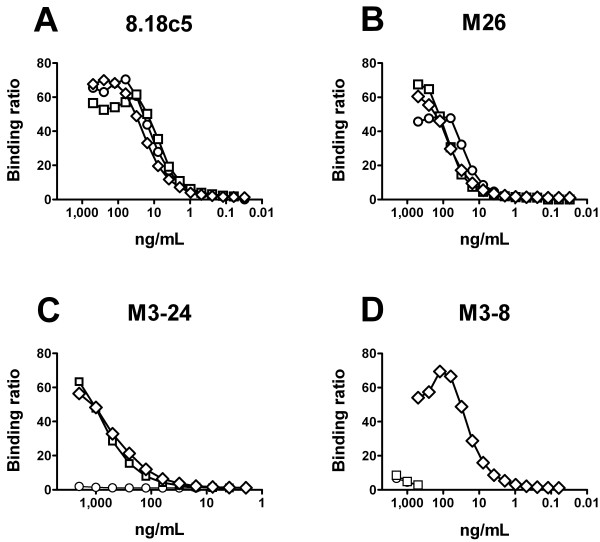
Monoclonal reagents define distinct epitopes on MOG. Serial two-fold dilution series of the mouse monoclonal antibody 8.18c5 (A), and the marmoset-derived Fab fragments M26 (B), M3-24 (C) and M3-8 (D) against rhMOG118 (-○-), rhMOG125 (-□-) and ratMOG125 (-◊-).